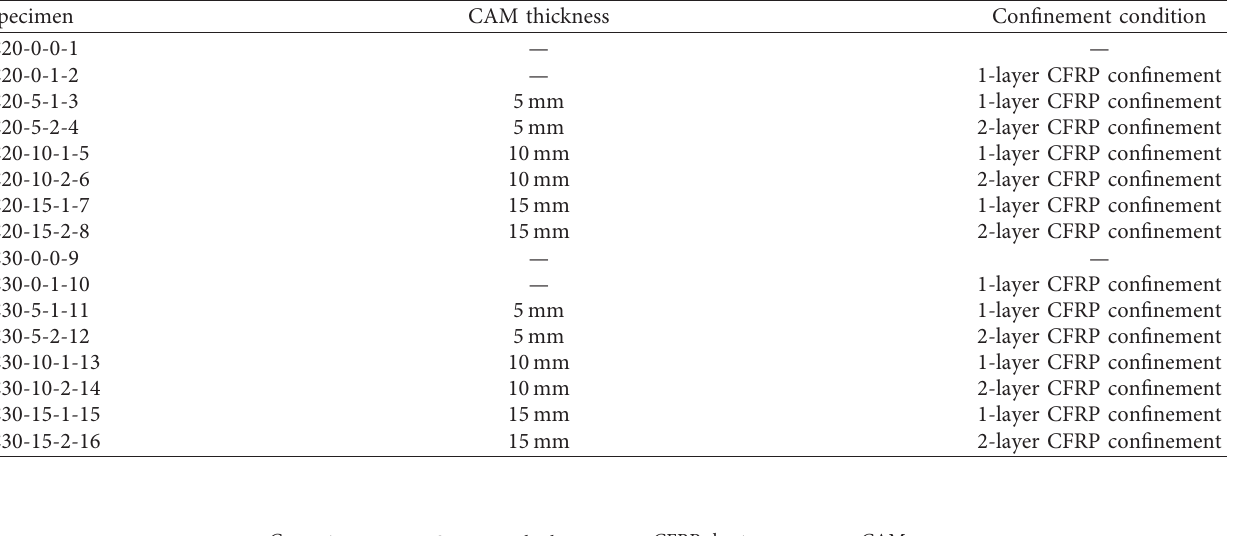
Table 2: Test parameters of specimens.